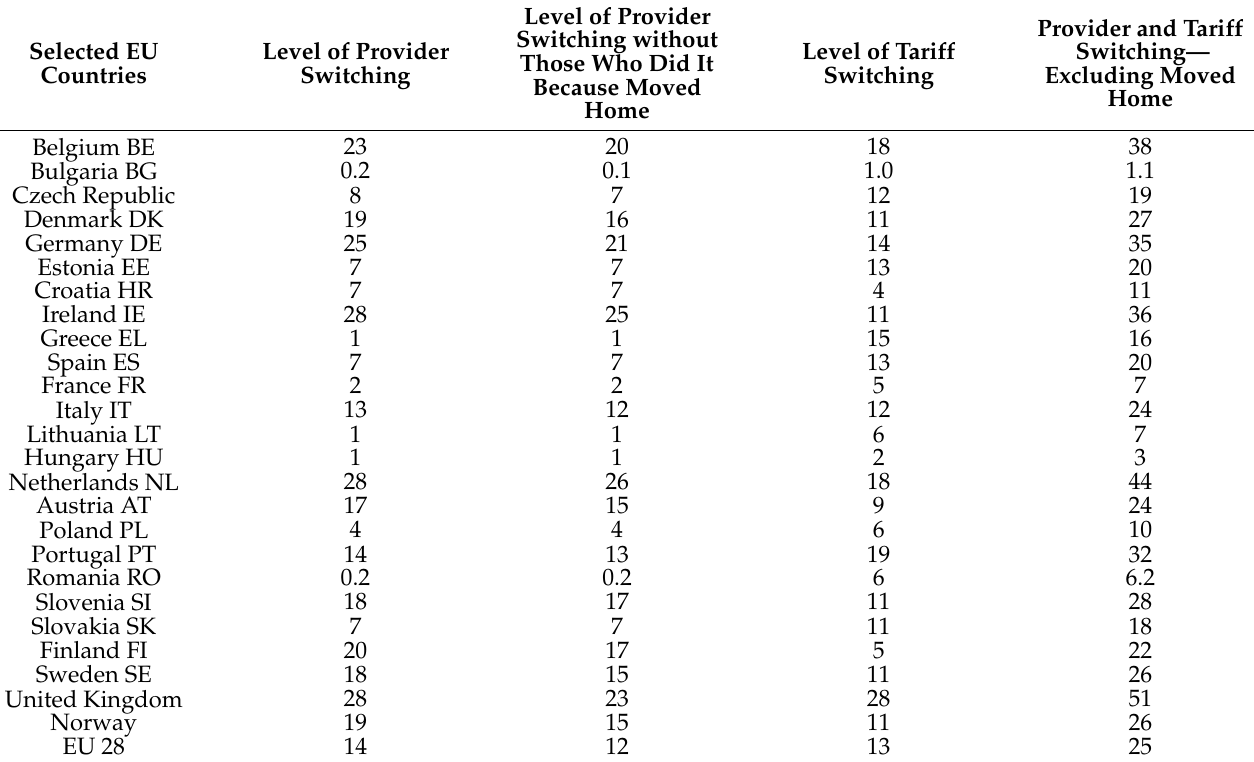
Table 1. Percentage of people changing energy suppliers or tariffs among citizens of selected EU countries in 2013–2015. Level of Provider Provider and Tariff Switching without Level of Tariff Switching— Selected EU Level of Provider Those Who Did It Switching Excluding Moved Countries Switching Because Moved Home Home Belgium BE 23 20 18 38 Bulgaria BG 0.2 0.1